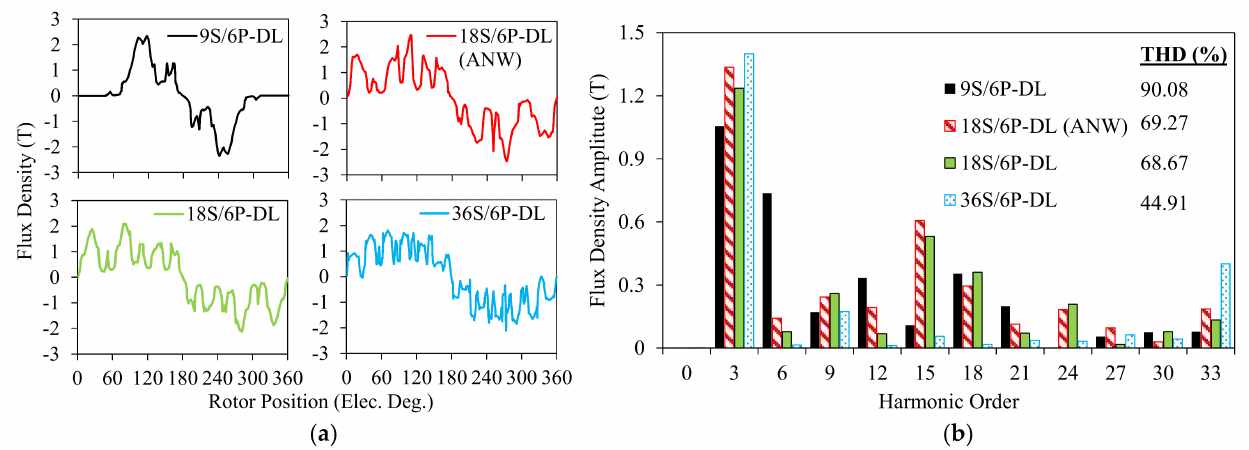
Figure 16. Air gap flux density: ( a ) waveforms and ( b ) harmonic spectra.